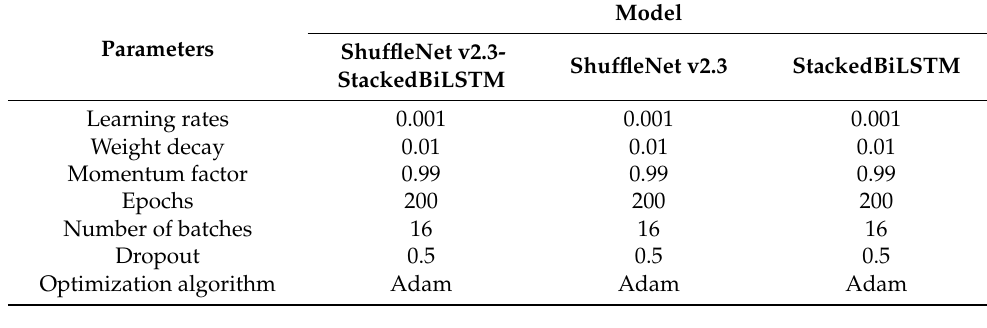
Table 5. Model specific parameters.